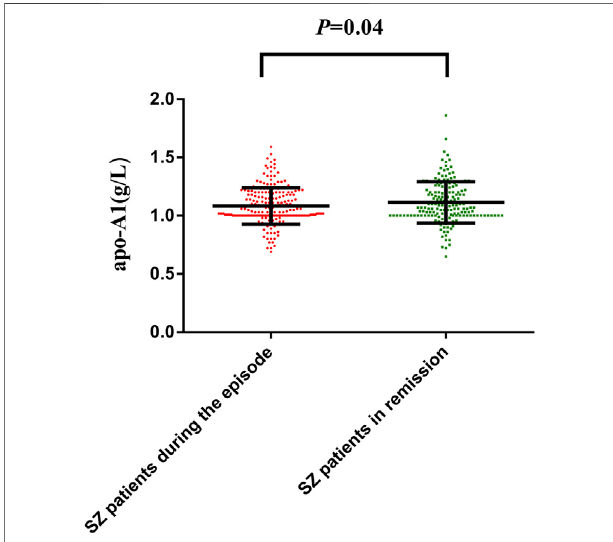
FIGURE3| DistributionofapoA1levelsinSZpatientsduringtheepisode and patients in remission with antipsychotic treatment. The dots represent individual data of apoA1. The upper line and lower line represent 75th percentage and 25th percentage, respectively, and the medium line represents the median. Comparison of apoA1 and HDL-C levels before and after antipsychotic treatment was assessed by Wilcoxon test. The apoA1 levels of209 SZ patients during the episode [1.03 (1.00.1.20) g/L] signi fi cantly increased after receiving an average 27.50 ± 9.90 days antipsychotic treatment [1.08 (1.00.1.22) g/L], p -value was 0.04 ( Figure 3